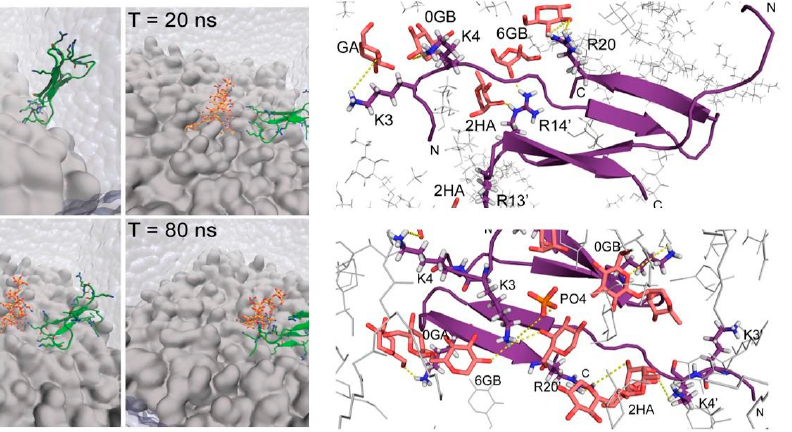
Figure 3. Molecular dynamics (MD) simulation of the interactions between LPS and thanatin. Left panel: time course of the binding of thanatin to LPS in a bilayer observed in the simulation. Right panel: interactions of residues of thanatin with LPS head groups [27].